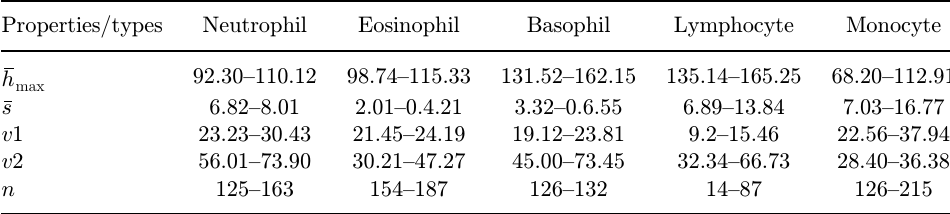
Table 4. Texture features of WBC extracted by